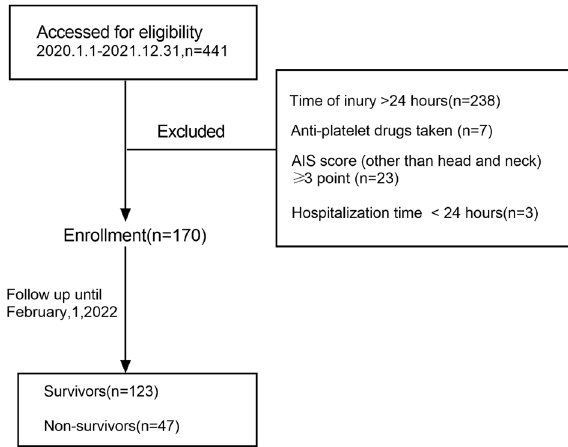
Figure 1. Study flow chart.